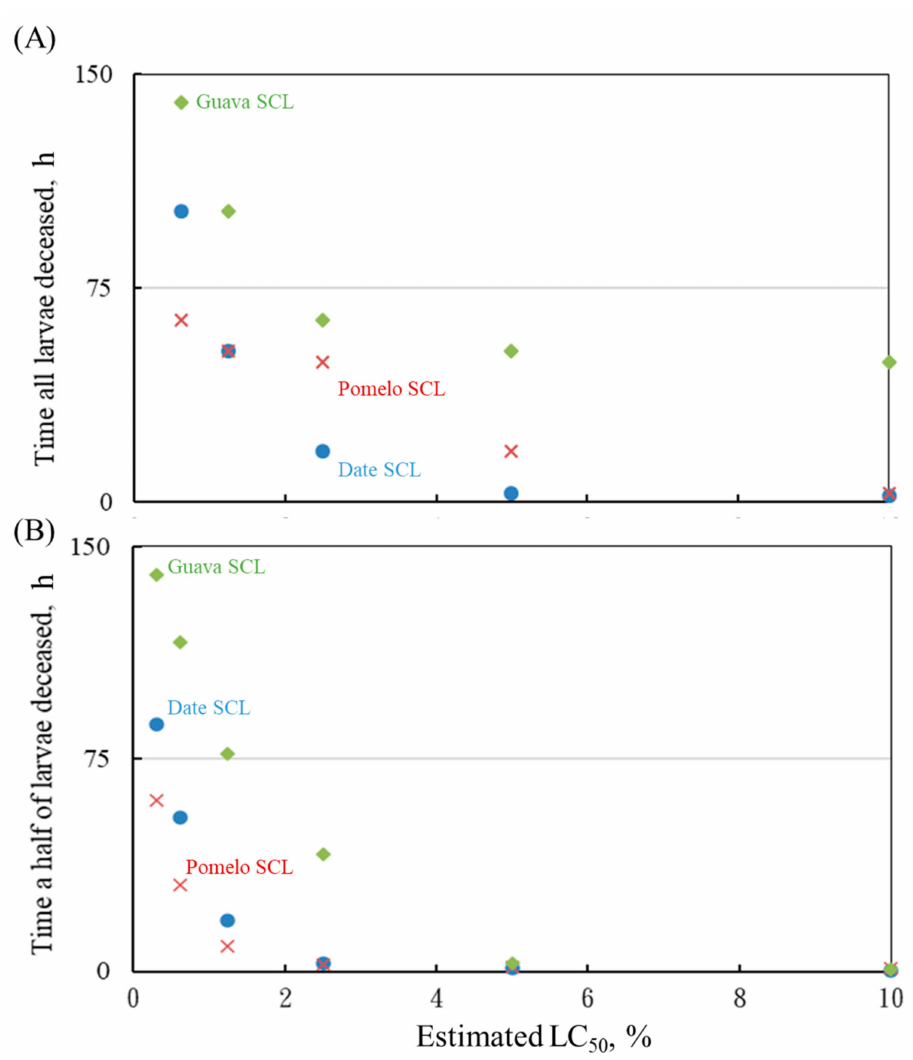
Figure 7. Plots of completely larvae mortality time ( A ) and a half larvae mortality time ( B ) versus the estimated LC 50